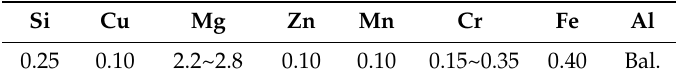
Table 3. Chemical composition of 1060 pure Al (mass fraction, %).